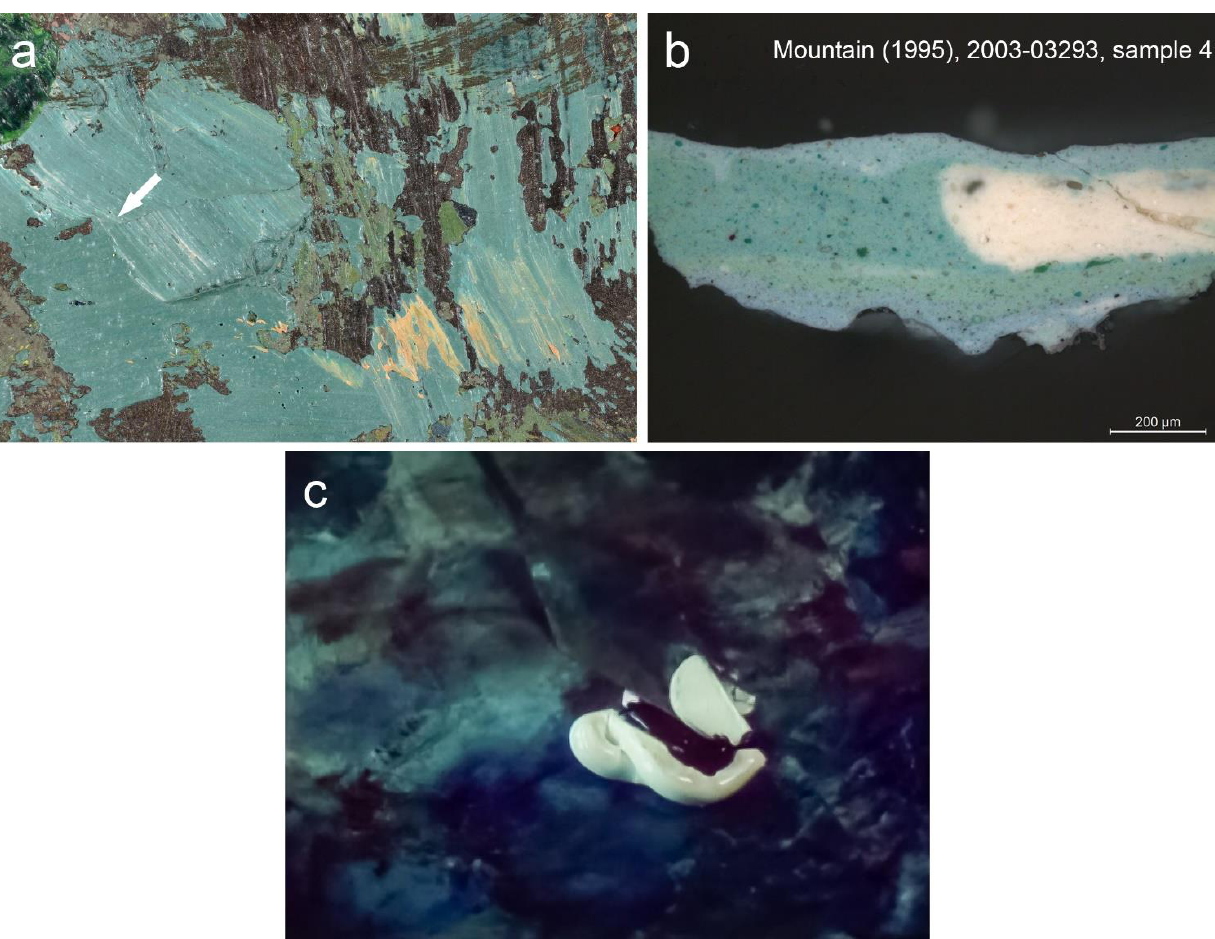
Figure 22. ( a ) Detail of partially mixed paint in Mountain , 1995. The arrow indicates the sampling spot. ( b ) Microscopy image of the cross-section of sample 4 taken from the sampling spot. ( c ) Still image from the 1982 TV documentary evidencing that the artist’s paint mixing technique resulted in a partially mixed paint application. Copyrights of Mediacorp TV Singapore Pte Ltd.